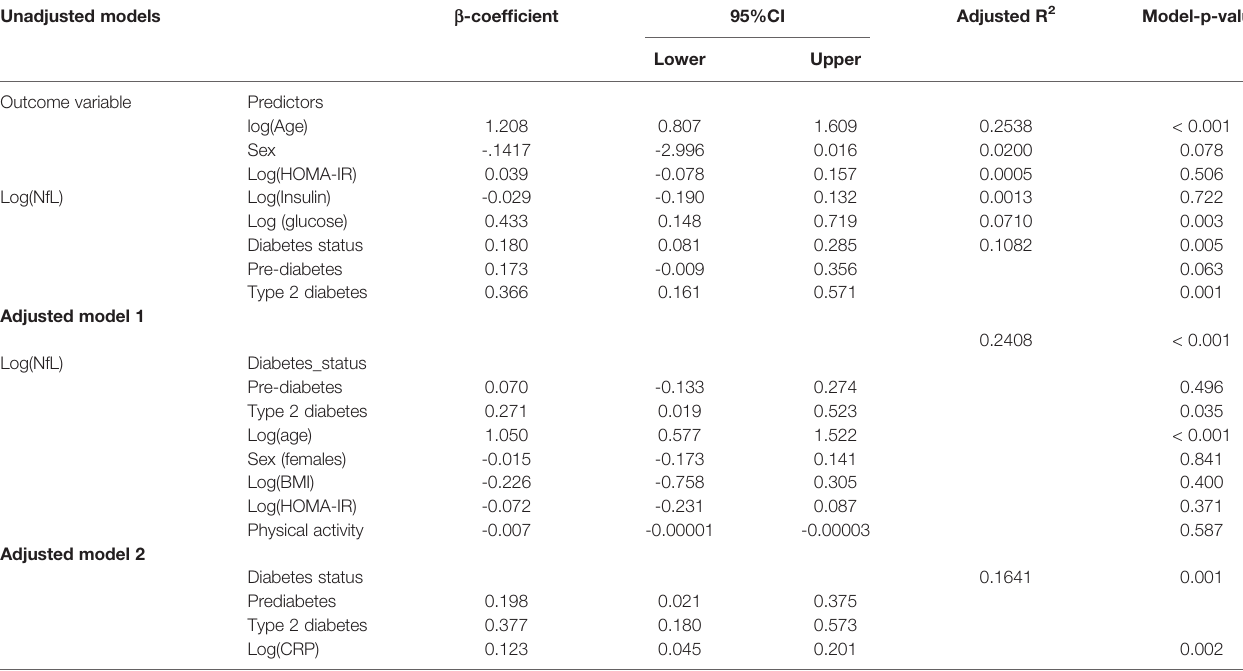
TABLE 2 | Linear regression models for predictors of plasma neuro fi lament light (NfL) levels. Unadjusted